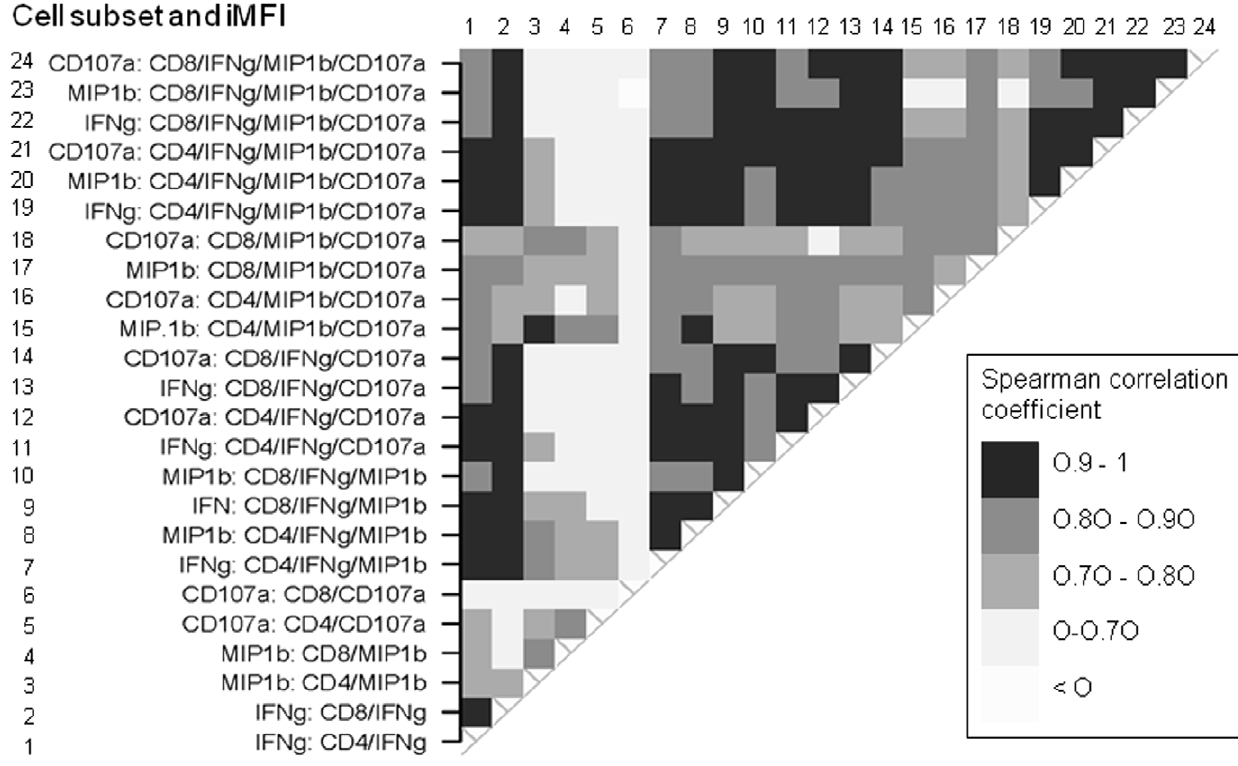
Figure 8. Heat map of Spearman correlation coefficients for iMFI values in various cell populations after intra-individual comparison for all donors. Integrated MFI values were obtained for all three functional markers (IFN- c , MIP-1 b , CD107a) in all mono-, bi- and trifunctional T-cell subsets and for all donors using Clust semi-automated gating. The iMFI values (24 values per PBMC sample, identified by numbers 1–24) from recall stimulation with 0.1 cfu ffLVS/PBMC were compared and lined up in a two-dimensional matrix. Correlated data are marked by shades of grey depending on the strength of the correlation coefficients; a coefficient above 0.7 is considered to indicate very strong correlation.